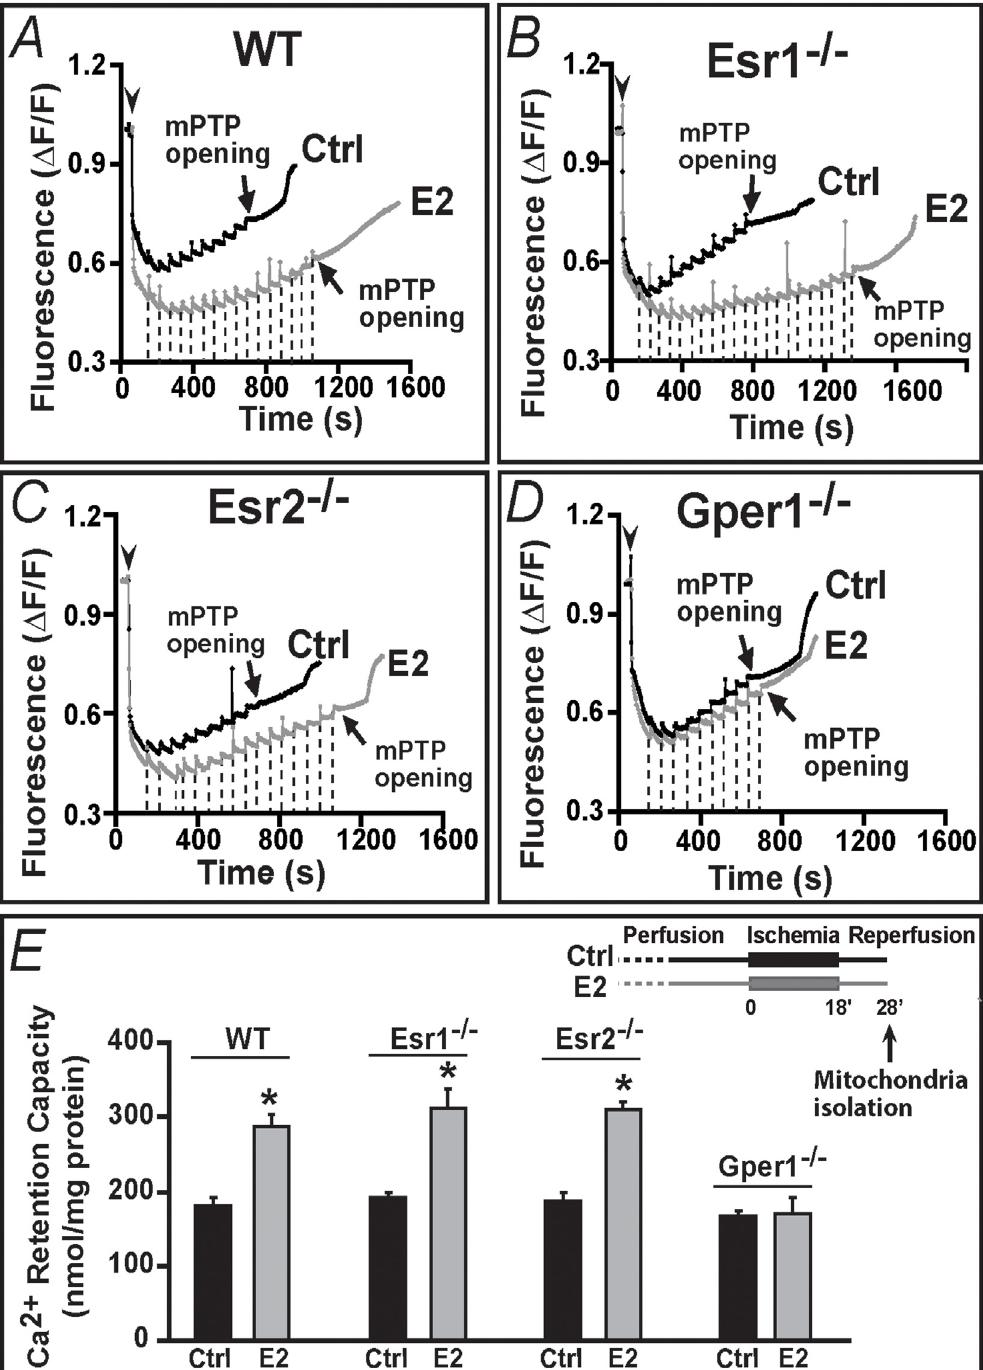
Fig 5. Gper1 activation is essential for E2 to induce increased resistance to Ca 2+ -overload of mitochondria from ischemic-reperfused hearts. A-D. Spectrofluorometric recordings of Ca 2+ overload in mitochondria isolated from WT ( A ) Esr1 -/- ( B ), Esr2 -/- ( C ) and Gper1 -/- ( D ) hearts subjected to I/R ( E , inset) in presence of vehicle (Ctrl, black traces) or E2 (gray traces). Arrowheads mark the time of mitochondria addition and the initial mitochondrial Ca 2+ uptake. Subsequent 10 nmol Ca 2+ pulses (dashed lines; only shown for E2 treated) were delivered until a spontaneous massive release was observed presumably to the opening of mPTP (arrows). Only mitochondria from Gper1 -/- lost their ability to endure higher Ca 2+ overload by E2 treatment ( D ). E. Mean Ca 2+ retention capacity values (amount of Ca 2+ load needed to induce mPTP opening). Inset. I/R protocol marking the time of mitochondria isolation (10 min after reperfusion begun). Values are expressed as mean ± SEM; * P < 0.05 control versus E2-treated groups (n = 5 hearts/group).